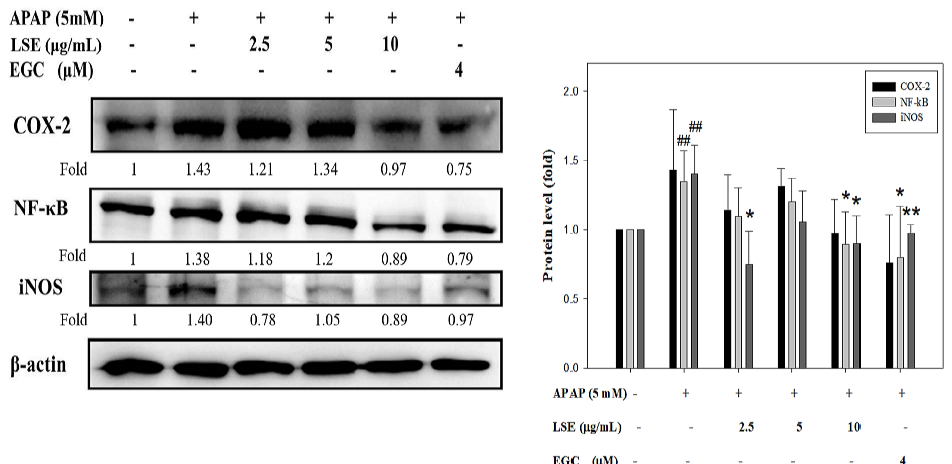
Figure 5. Effect of LSE and EGC on inflammatory factors in toxic APAP-treated HepG2 cells. HepG2 cells were treated with APAP (5 mM) in the presence or absence of LSE (2.5, 5, 10 µg/mL) or EGC (4 µM) for 24 h. The protein levels of COX-2, NF- κB, and iNOS were analyzed by Western blotting. β -actin served as an internal control. The quantitative data are presented as means ± SD of three independent experiments. ## p <0.01 compared with the control group. * p < 0.05, ** p < 0.01 compared with the APAP group.